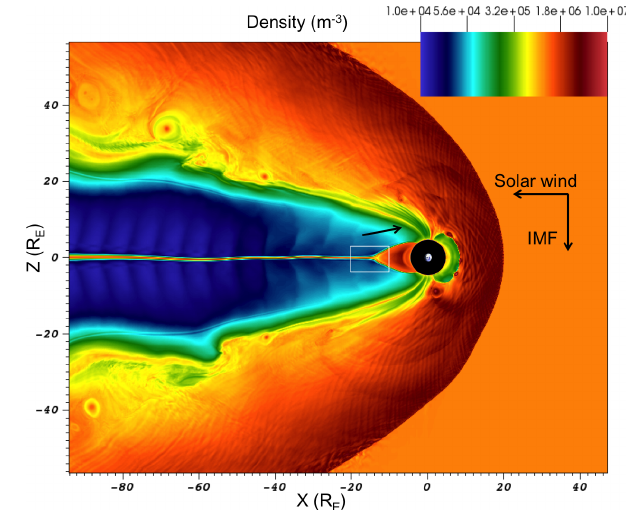
Figure 1. The plasma density in the Earth’s magnetosphere as de- picted by the Vlasiator simulation in the geocentric solar ecliptic (GSE) coordinate system used in this paper. Figure 1 is a snapshot of Supplement movie S1 showing the entire simulation sequence in time. The white rectangle in the tail shows the zooming area in Fig. 2 and in Supplement movie S2. The arrow inside the magne- topause is discussed later in connection to Fig. 4.